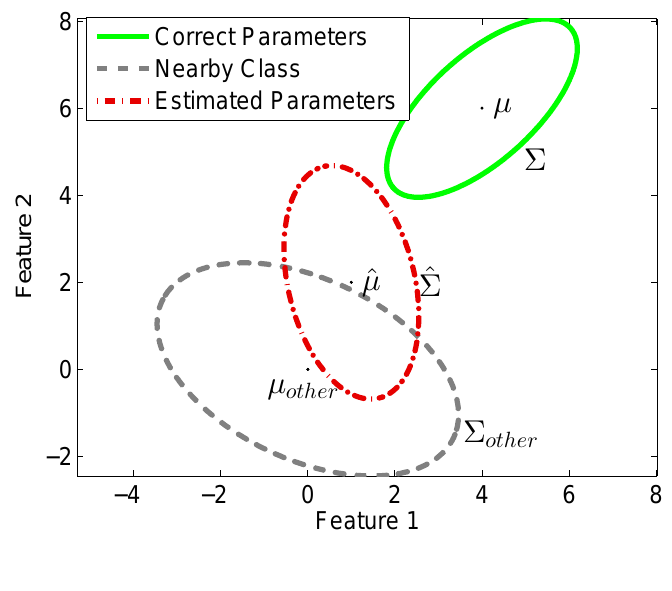
Figure 3. Simulated distributions.